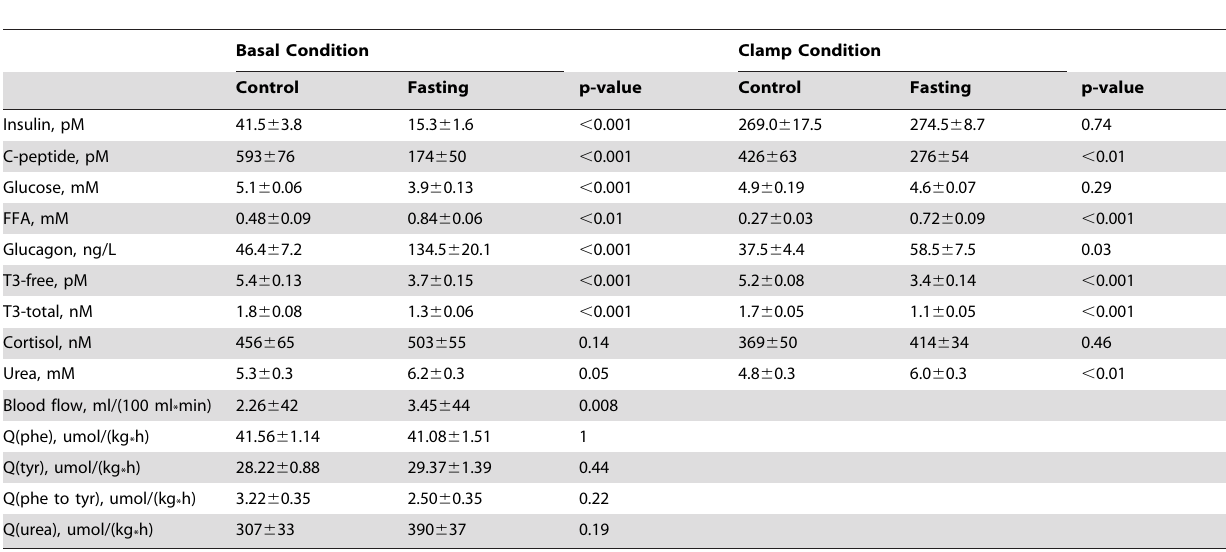
Table 1. Insulin, C-peptide, glucose, FFA, glucagon, cortisol, T3-free, T3-total, and urea concentration in serum were determined at examination days during basal and clamp conditions (t= 30 and t= 270, respectively).